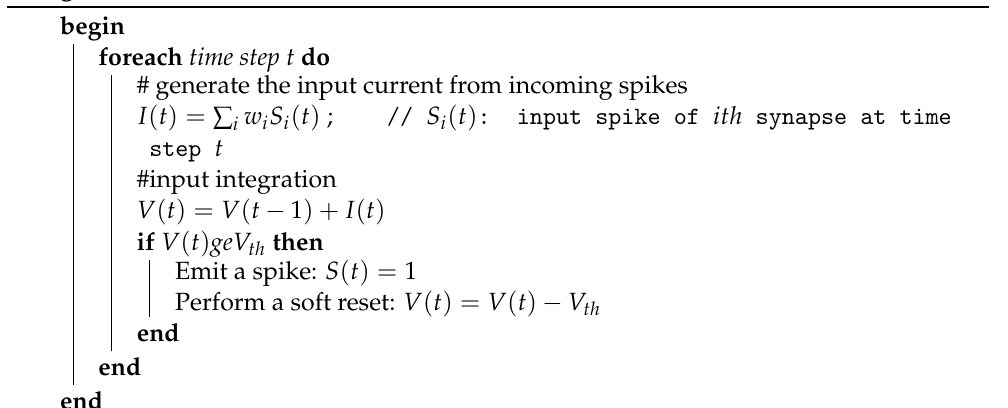
Algorithm A2: Behavior of a soft-reset IF neuron